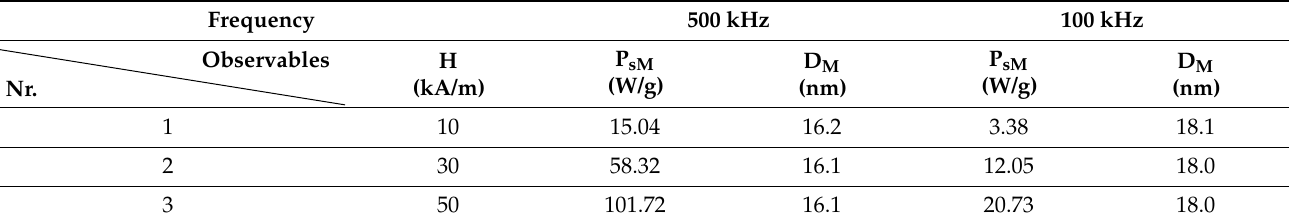
500 kHz 100 kHz